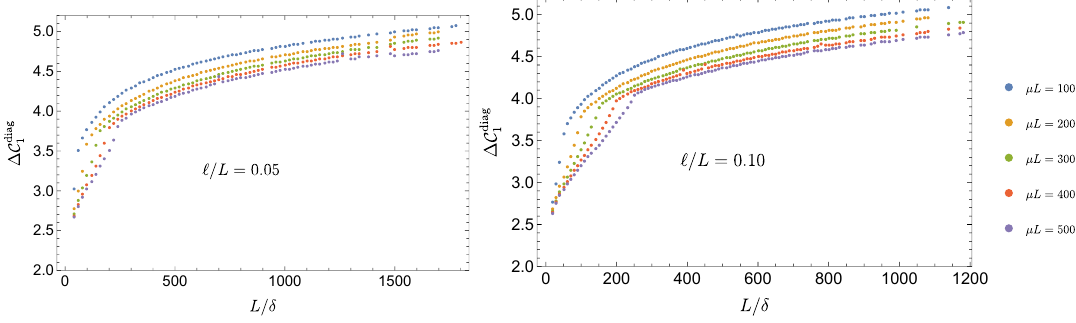
for di(cid:11)erent 1